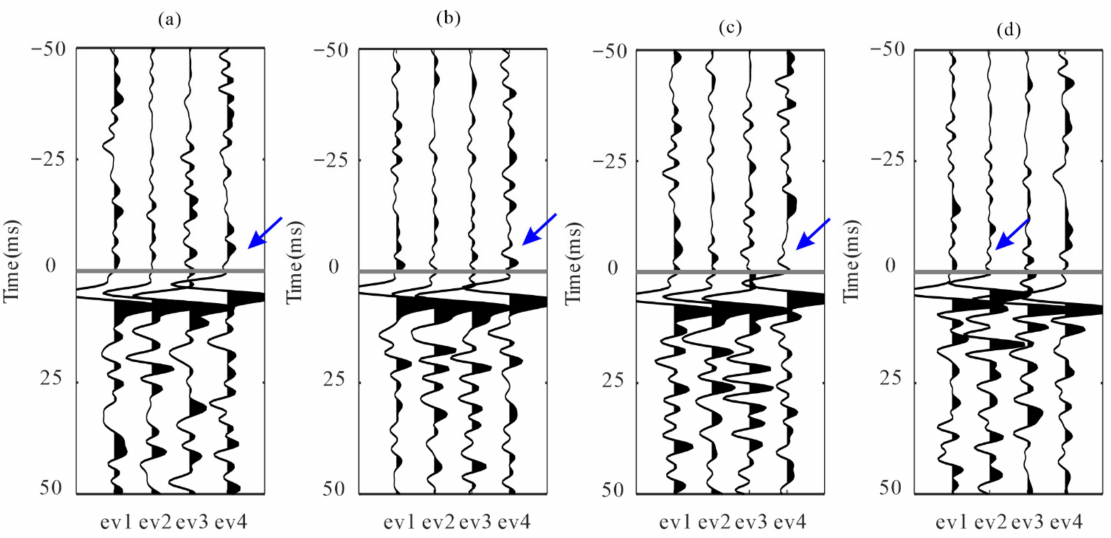
Figure 13. Common-receiver gathers of x -components flattened using P pick times. The horizontal gray line represents the location of P-wave arrivals. ( a ) Receiver No.2; ( b ) Receiver No.5; ( c ) Receiver No.6; ( d ) Receiver No.8. The blue arrows indicate the local inconsistencies between waveforms from different